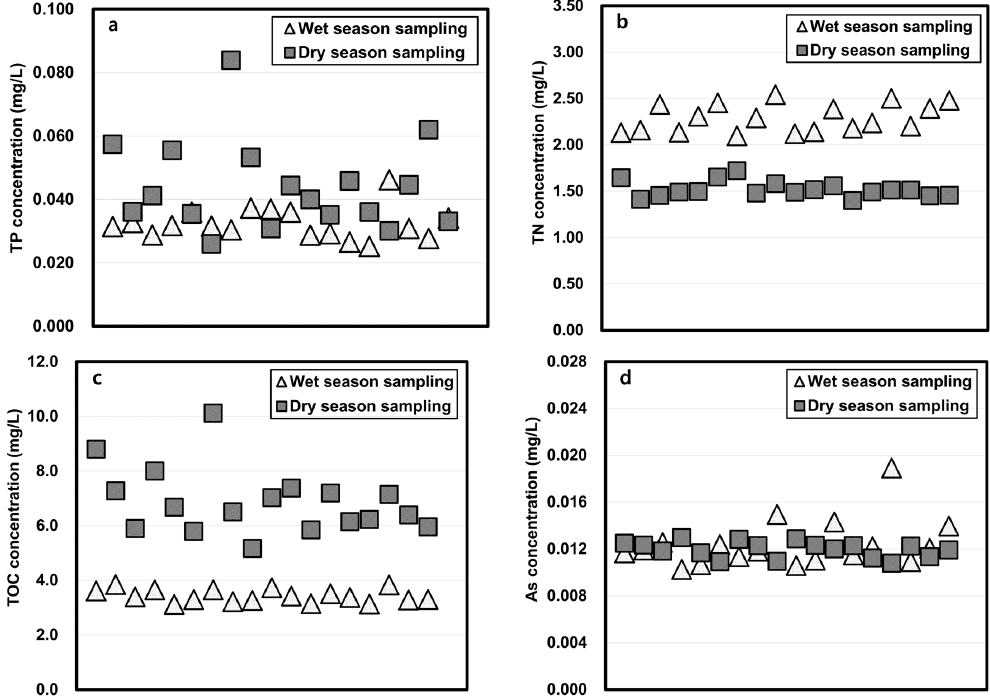
Figure 3. Physicochemical properties of reservoir water in wet and dry seasons. ( a : TP, b : TN, c : TOC, d : As)